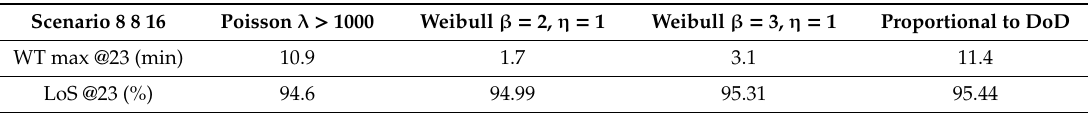
Table 2. Comparison of maximum WT and LoS with di ff erent probability distribution for charging duration, with mean equal to 23